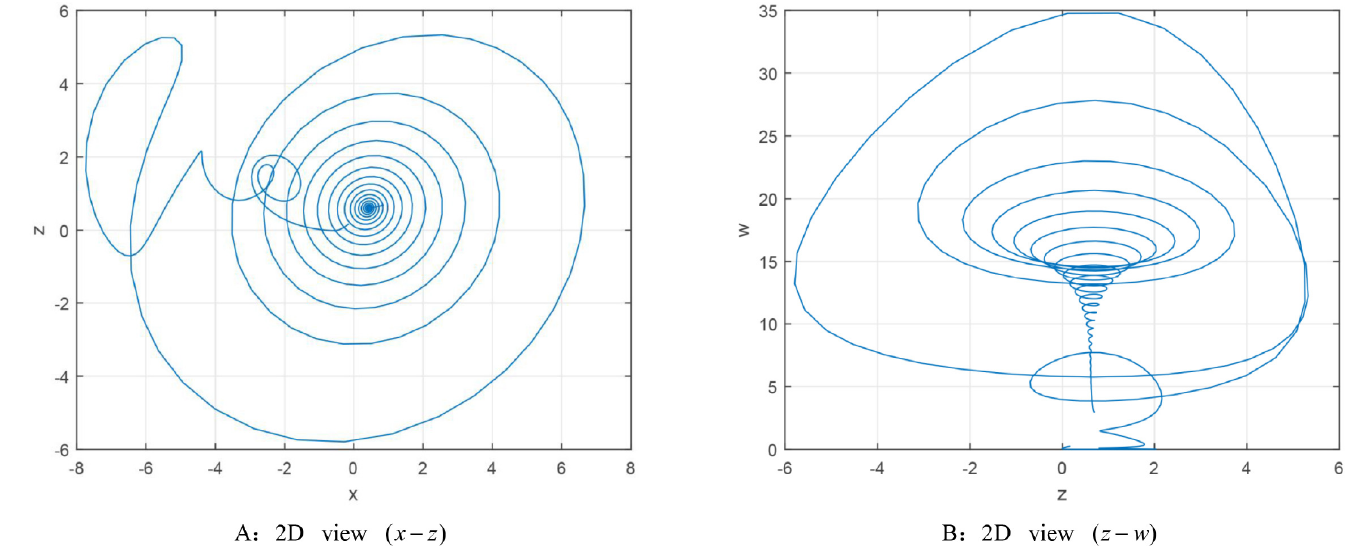
Fig 7. The 2D phase diagram of the 4D actual system.